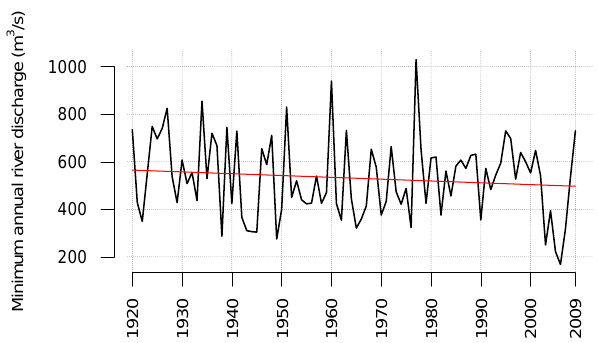
Fig. 6. Annual minima of the Po River at Pontelagoscuro daily dis- charge series (1920–2009) and linear regression line.